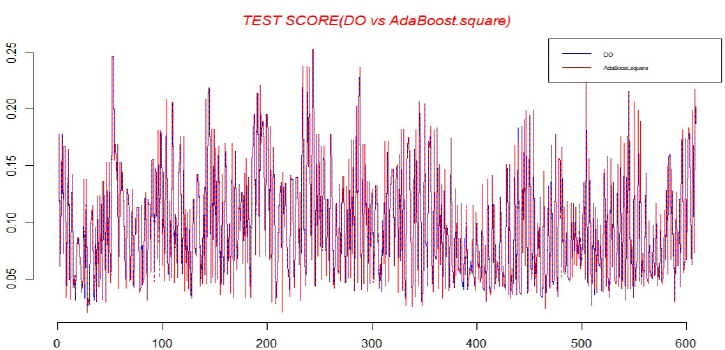
Figure 7. Train score (AdaBoost).